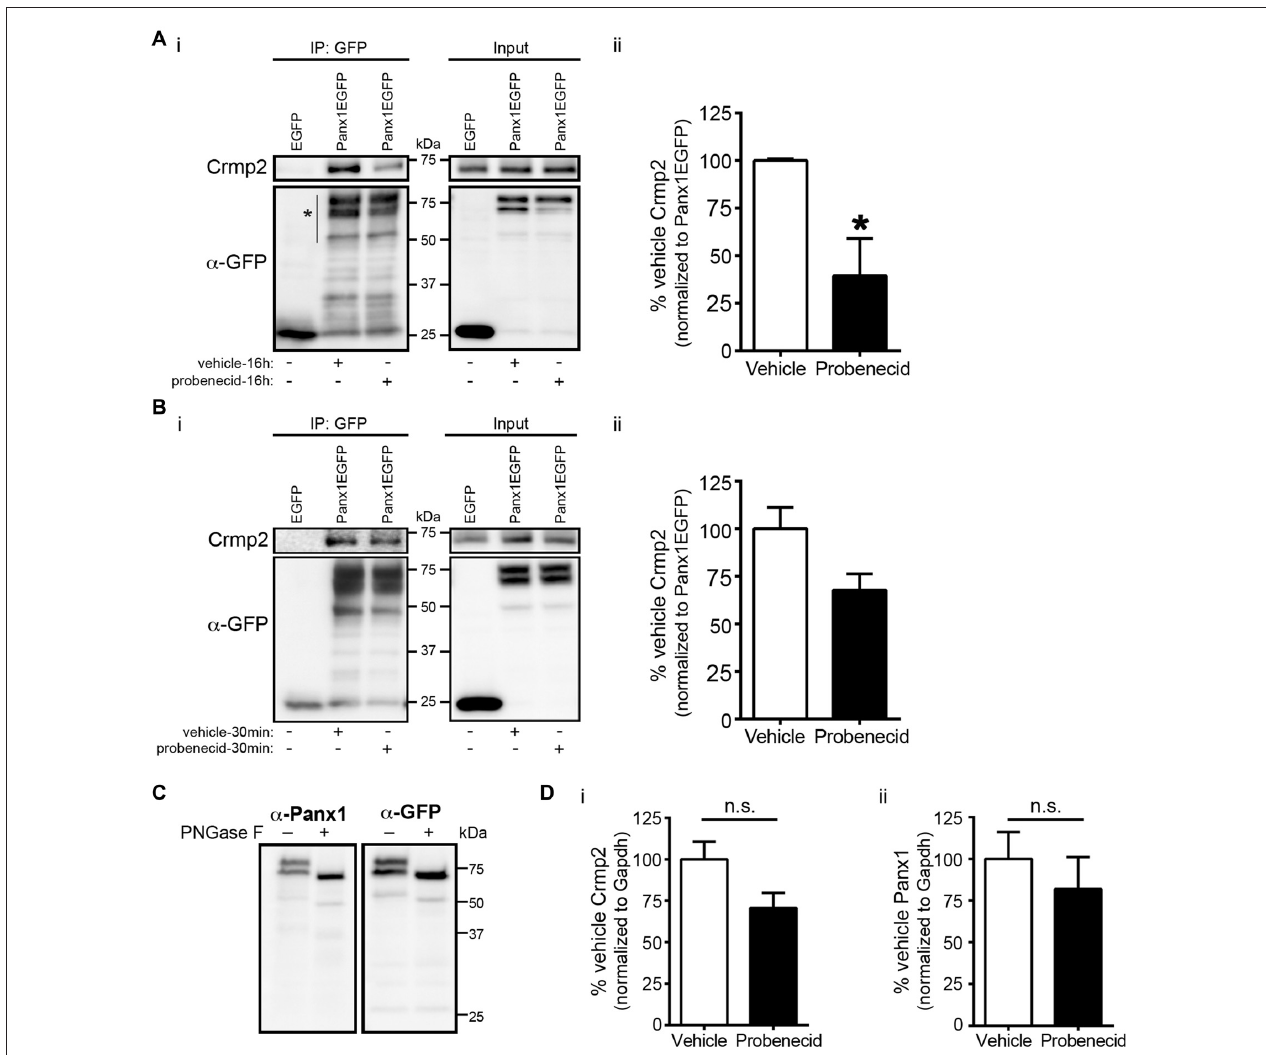
FIGURE 3 | Probenecid treatment decreases Crmp2 co-precipitation with Panx1. (Ai) Western blot of a GFP IP from N2a cells expressing Panx1-EGFP, or EGFP control, treated (16 h) with probenecid or vehicle control. (ii) Probenecid treatment (16 h) significantly decreased the amount of Crmp2 that precipitated with Panx1-EGFP. Crmp2 signal in the IP fraction was normalized to GFP signal intensity from the same lane (Panx1-EGFP [vehicle] vs. Panx1-EGFP [probenecid]: 100.0 ± 0.8 vs. 39.4 ± 19.6, p = 0.0368, n = 3, unpaired t -test). (B) The same assay was performed with a shorter 30 min treatment (i) . (ii) Short probenecid treatment (30 min) revealed a ∼ 30% decrease in Crmp2 co-precipitation (Panx1-EGFP [vehicle] vs. Panx1-EGFP [probenecid]: 100.0 ± 11.1 vs. 67.7 ± 19.6, p = 0.0826, n = 3, unpaired t -test). (C) PNGase F treatment was performed to confirm the upper Panx1EGFP immunoreactive band was indeed glycosylated Panx1 and assessed by Western blotting. Note that both immunoreactive bands shifted in response to N-glycosidase F treatment, suggesting that both major bands are mature glycosylated Panx1EGFP of differing molecular weights. (D) Analysis of the input intensities revealed that probenecid treatment did not change the overall expression of (i) Crmp2 ( p = 0.2000, Mann-Whitney test, n = 3) or (ii) Panx1 ( p = 0.578, unpaired t -test, n = 3). Normalized to Gapdh (not shown), n.s.,